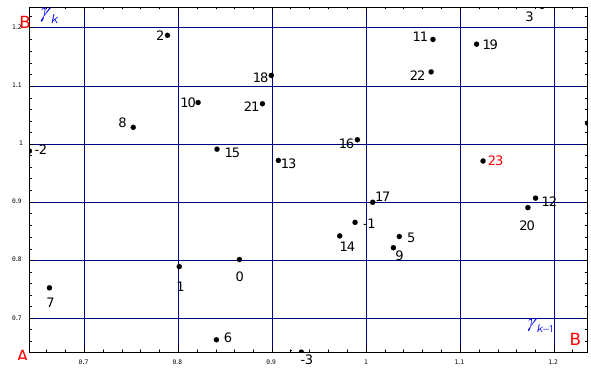
(cid:16) (cid:17) γ ∗ ,γ ∗ n pairs, with points numbered according n − 1